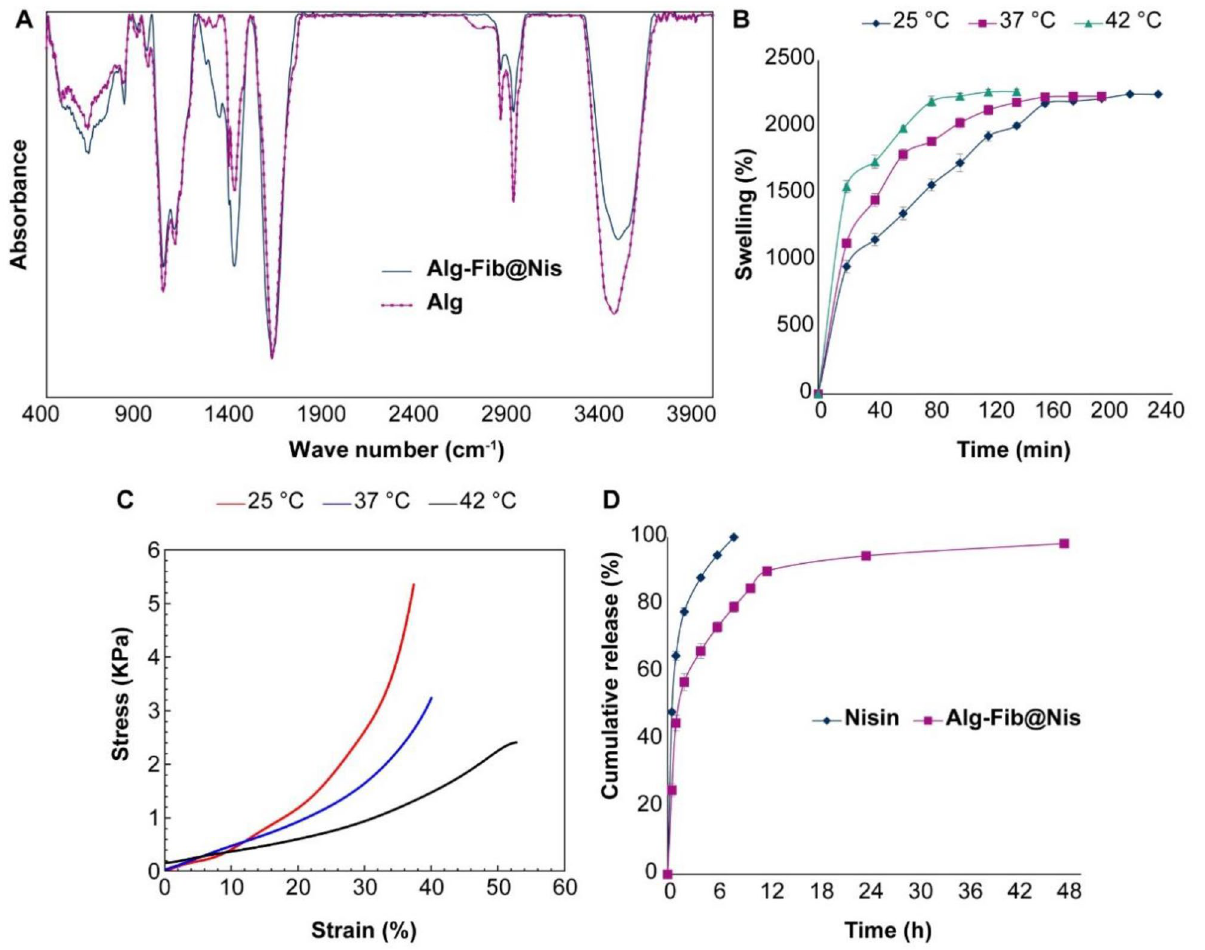
Figure 3. ( A ) FTIR spectra of Alg-Fib@Nis-EDTA hydrogel and alginate polymer. ( B ) The swelling percentages of the Alg-Fib@Nis-EDTA hydrogel over time at various temperatures. The highest swelling percentage was at 240 (2244 ± 13%), 200 (2229 ± 9%), and 140 (2264 ± 17%) min after the incubation at 25, 37 and 42 °C, respectively. Values are mean ± SD, n = 3. SD: standard deviation. ( C ) Stress–strain diagram of the hydrogels after swelling in 25, 37, and 42° C using the extension rate of 5 mm/min. ( D ) Release profile of nisin from Alg-Fib@ Nis-EDTA hydrogel compared to free nisin at different times in PBS at 37 °C. Data points are mean ± SD, (n = 3). SD: standard